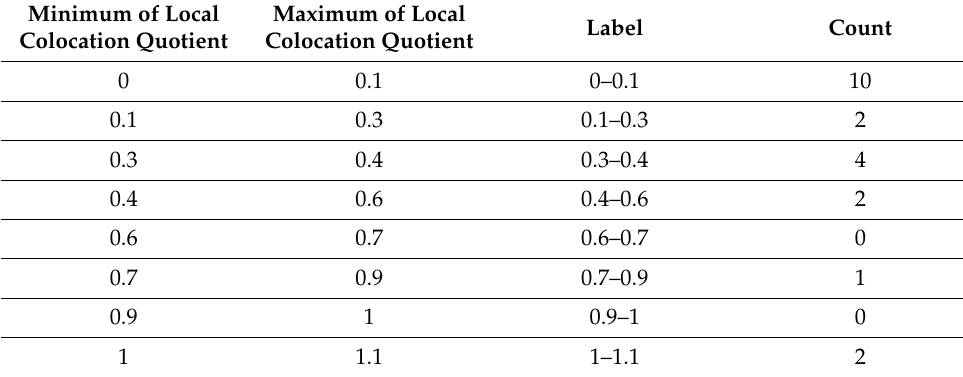
Figure 8. This graph shows the relationship between the Local Colocation Quotient and the p -value. With few exceptions, the Local Colocation Quotients indicate that the Wusun Kurgans are spatially isolated from the Saka Kurgans. There are two sites that are considered spatially isolated, yet not statistically significant. All other Wusun kurgans are significantly spatially isolated The colors in this figure correspond to the colors in Figure 10. Table 6. Minimum and Maximum Local Co-locations and their counts. We find that the majority of the Wusun Kurgans have local colocation quotients that indicate statistically significant spatial isolation